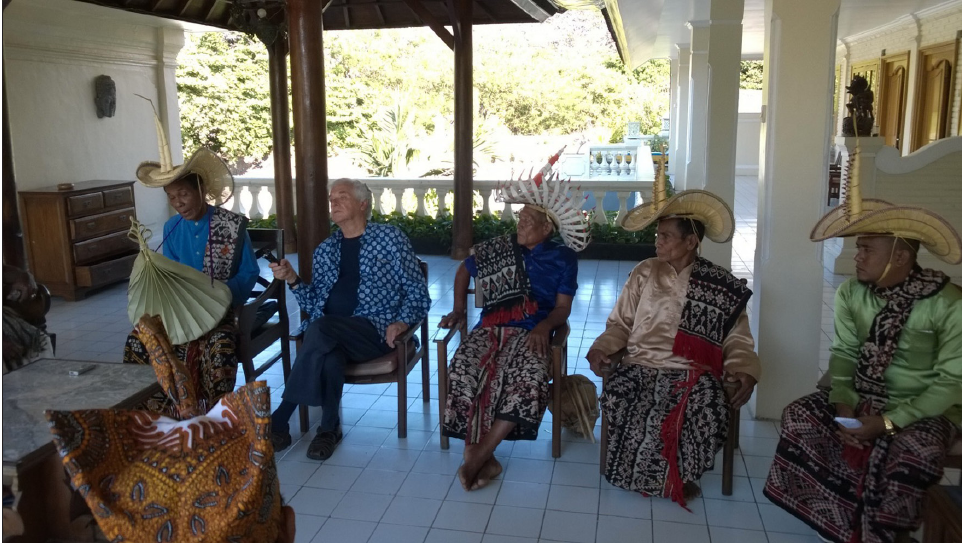
Figure 3: Jonas Mooy performs with his stringed instrument. From left to right: Jonas Mooy, James J. Fox, Ande Ruy, Kornalius Medah and Mikkris Ruy. (Photo: Frog, Bali,